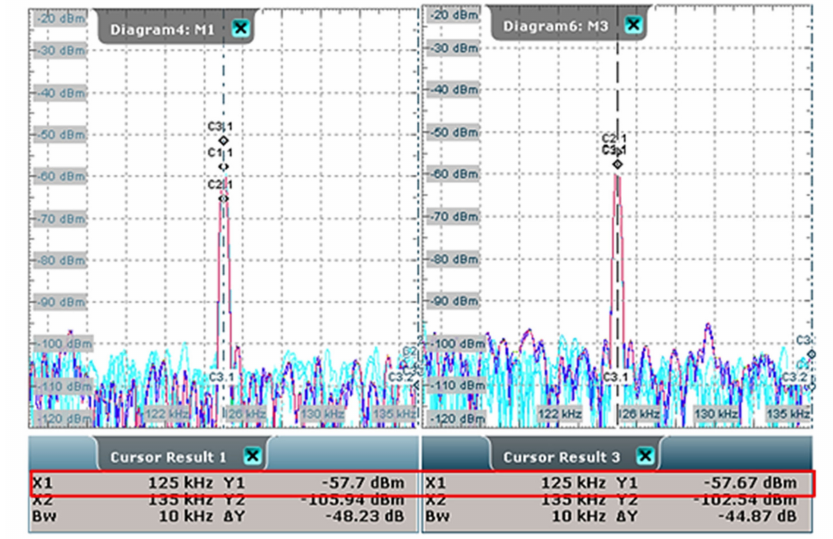
Figure 20. Oscilloscope measurement waveform results for vehicle-level experiments at the center alignment point of the EV WPT